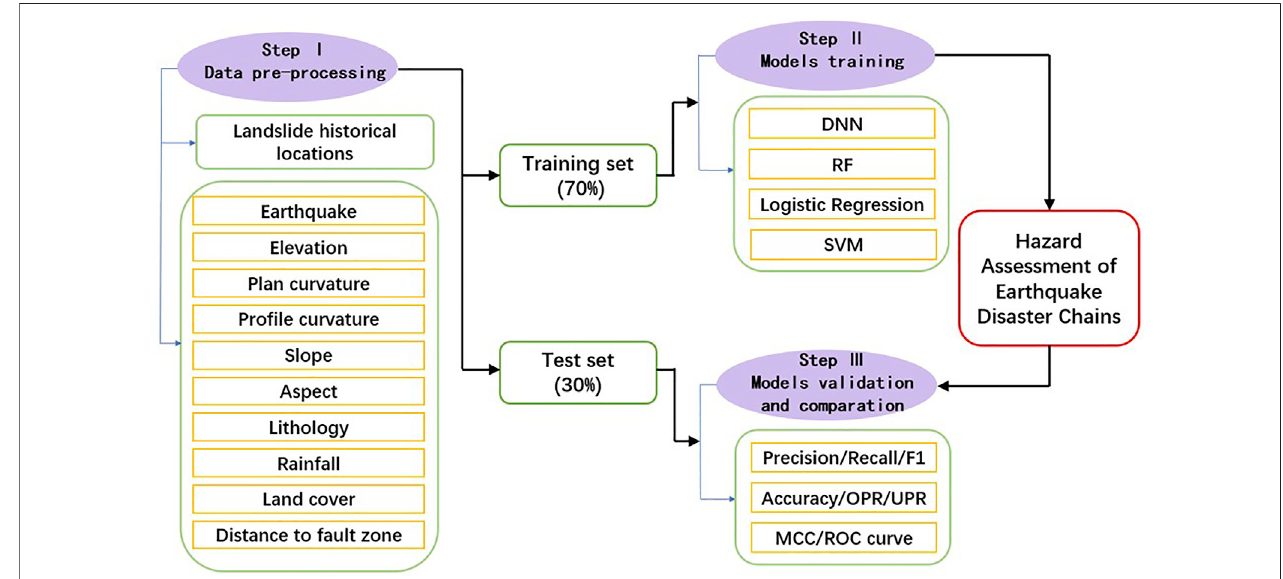
FIGURE 4 | Flow chart of this